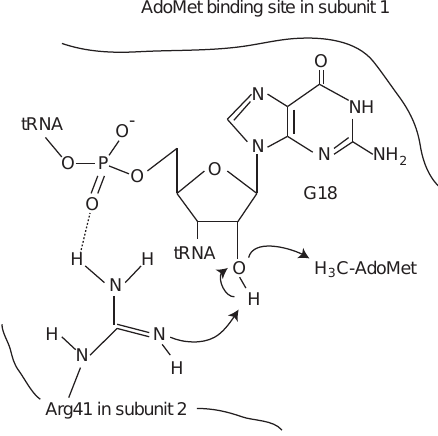
Figure 6. Schematic drawing of the hypothetical catalytic mechanism of T. thermophilus